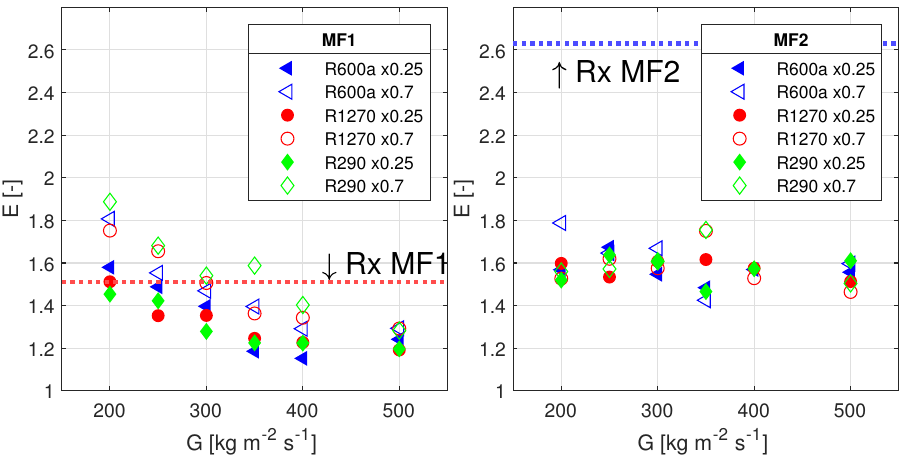
Figure 10. Effect of mass flux on enhancement factor, E , for MF tubes at x = 0.25 and x = 0.7, heat exchange area increase shown with R x